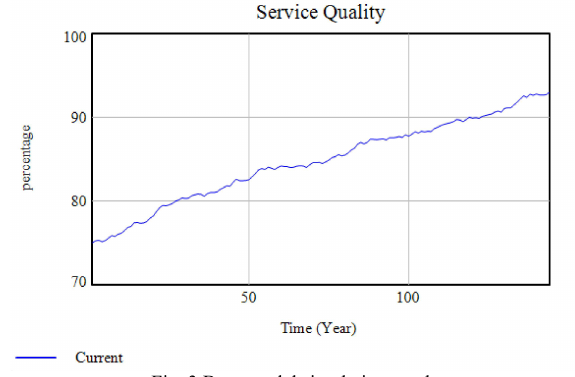
Fig. 3 Base model simulation